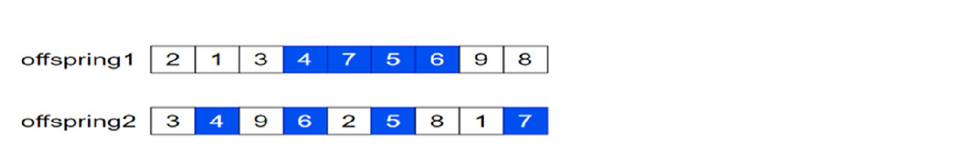
Figure 5. The genetic map of the two offspring generated during the gene crossover